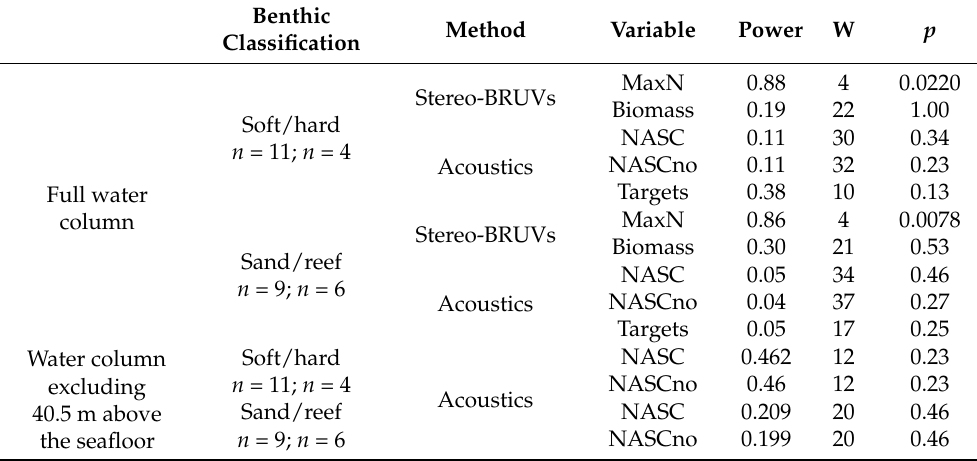
Table 3. Results of the Wilcox test comparing the relative biomass, relative abundance (MaxN) of the stereo-BRUVs and acoustic NASCBRUV-mean, NASCBRUV-mean no schools, and number of targets between benthic habitat classes. Both acoustic and visual classifications are shown. Significant differences are shown in